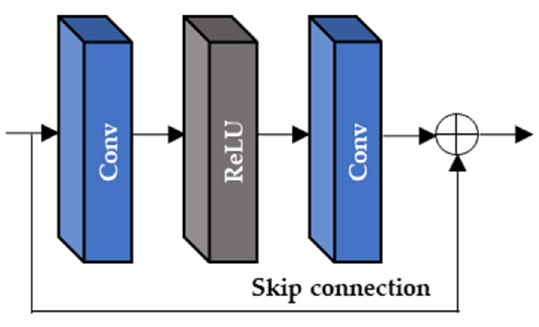
Figure 8. The Resblock of the proposed DCAN.